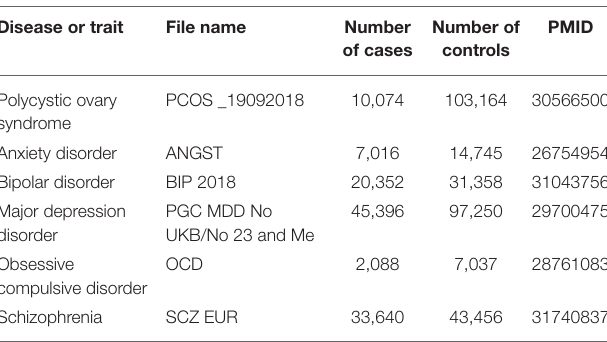
TABLE 1 | Overview of genome-wide association datasets for polycystic ovary syndrome and five psychiatric disorders. Disease or